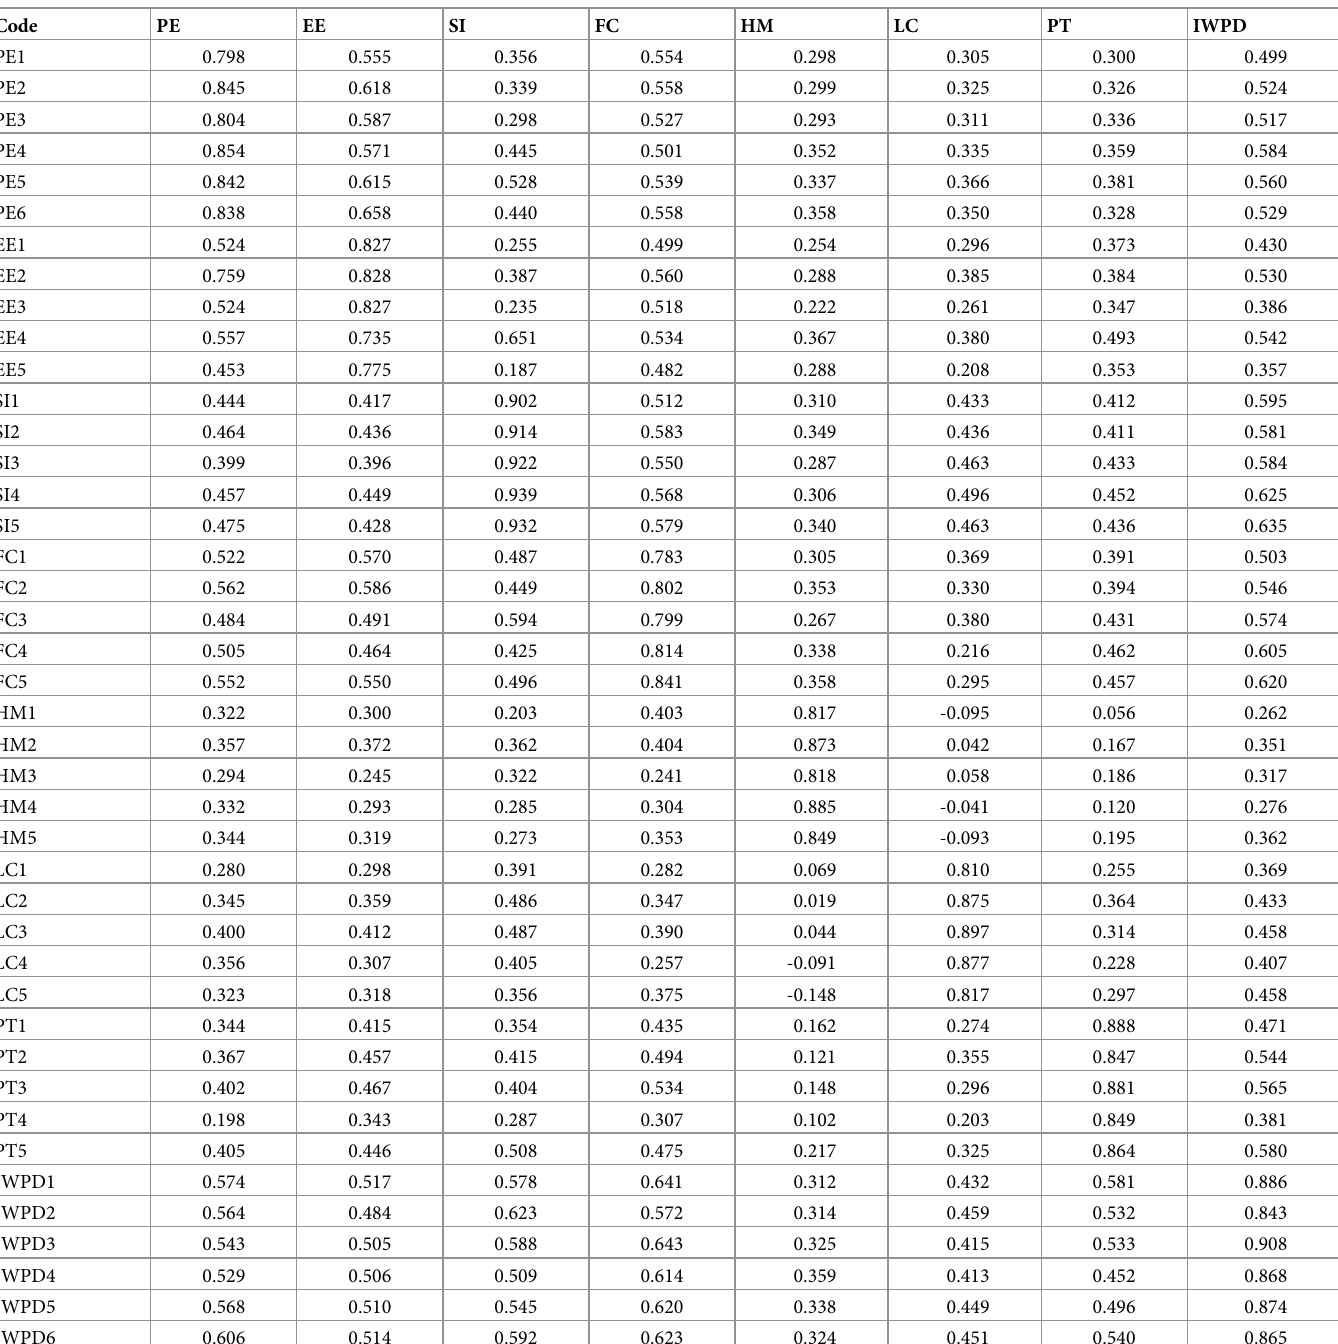
Table 6. Loadings and